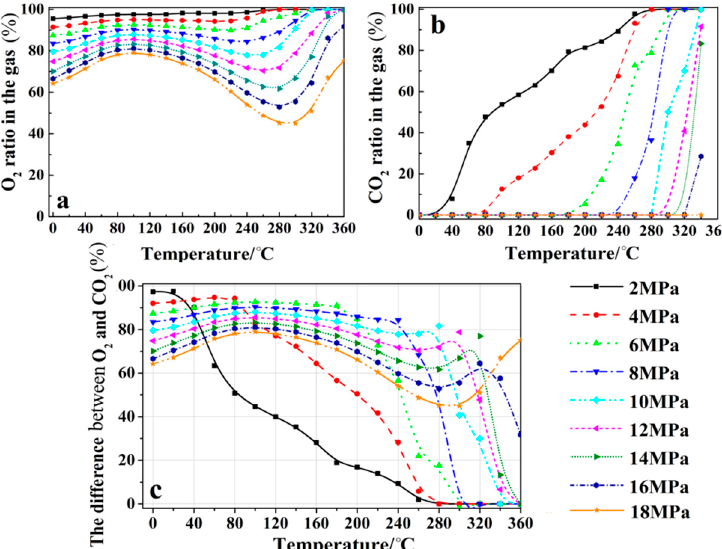
Figure 2. The releasing ratio difference between oxygen and carbon dioxide at different pressures and temperatures based on our previous experimental results, in the reactor effluent, water flow: 46.044 kg/h, oxygen flow: 0.448 kg/h, carbon dioxide flow: 0.836 kg/h, ( a ) O 2 ratio in the gas, ( b ) CO 2 ratio in the gas, ( c ) the ratio difference between O 2 and CO 2 .